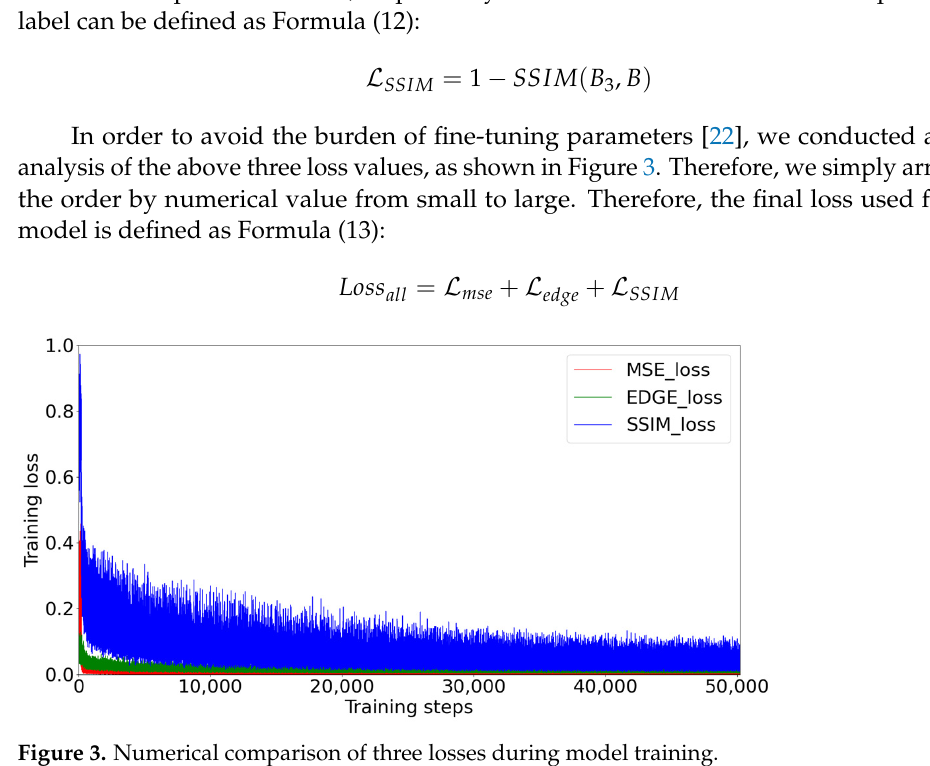
Figure 3. Numerical comparison of three losses during model